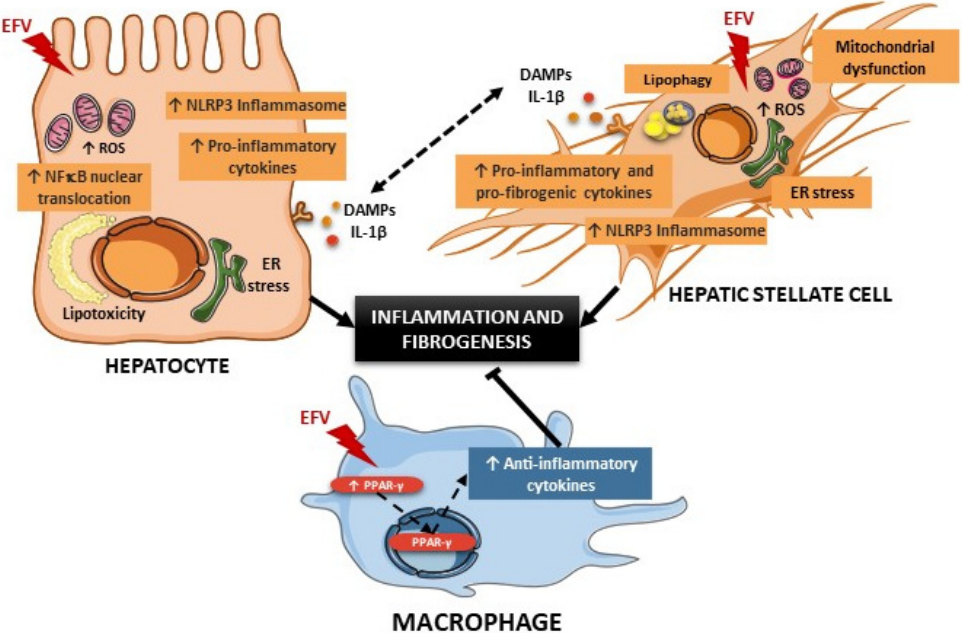
Figure 9. Schematic summary of the potential crosstalk between hepatocytes, hepatic stellate cells and macrophages in the liver following Efavirenz (EFV) treatment. In hepatocytes, EFV induces endoplasmic reticulum (ER) stress and mitochondrial dysfunction characterized by an enhanced reactive oxygen species (ROS) production and mitochondrial mass, and a reduction in mitochondrial membrane potential ( ΔΨ m ) and ATP levels, which leads to an accumulation of intracellular lipids [8,9,11]. These cellular events are associated with an increased nuclear translocation of NF- κ B, which upregulates the expression of pro-inflammatory cytokines and the NLRP3 inflammasome. EFV also activates hepatic stellate cells, an effect associated with several EFV-induced actions such as enhanced oxidative stress and ER stress, and lipophagy. Moreover, EFV upregulates pro-inflammatory and fibrogenic mediators in these cells. Importantly, in both hepatocytes and hepatic stellate cells, EFV activates the NLRP3 inflammasome, which can lead to the release of damage-associated molecular patterns (DAMPs), amplifying the inflammatory response. Conversely, EFV produces macrophage polarization towards the anti-inflammatory/pro-resolving M2 phenotype, as shown by an increased expression of PPAR- γ and anti-inflammatory cytokines, which alleviates the pro-inflammatory and pro-fibrogenic response in hepatocytes and hepatic stellate cells.